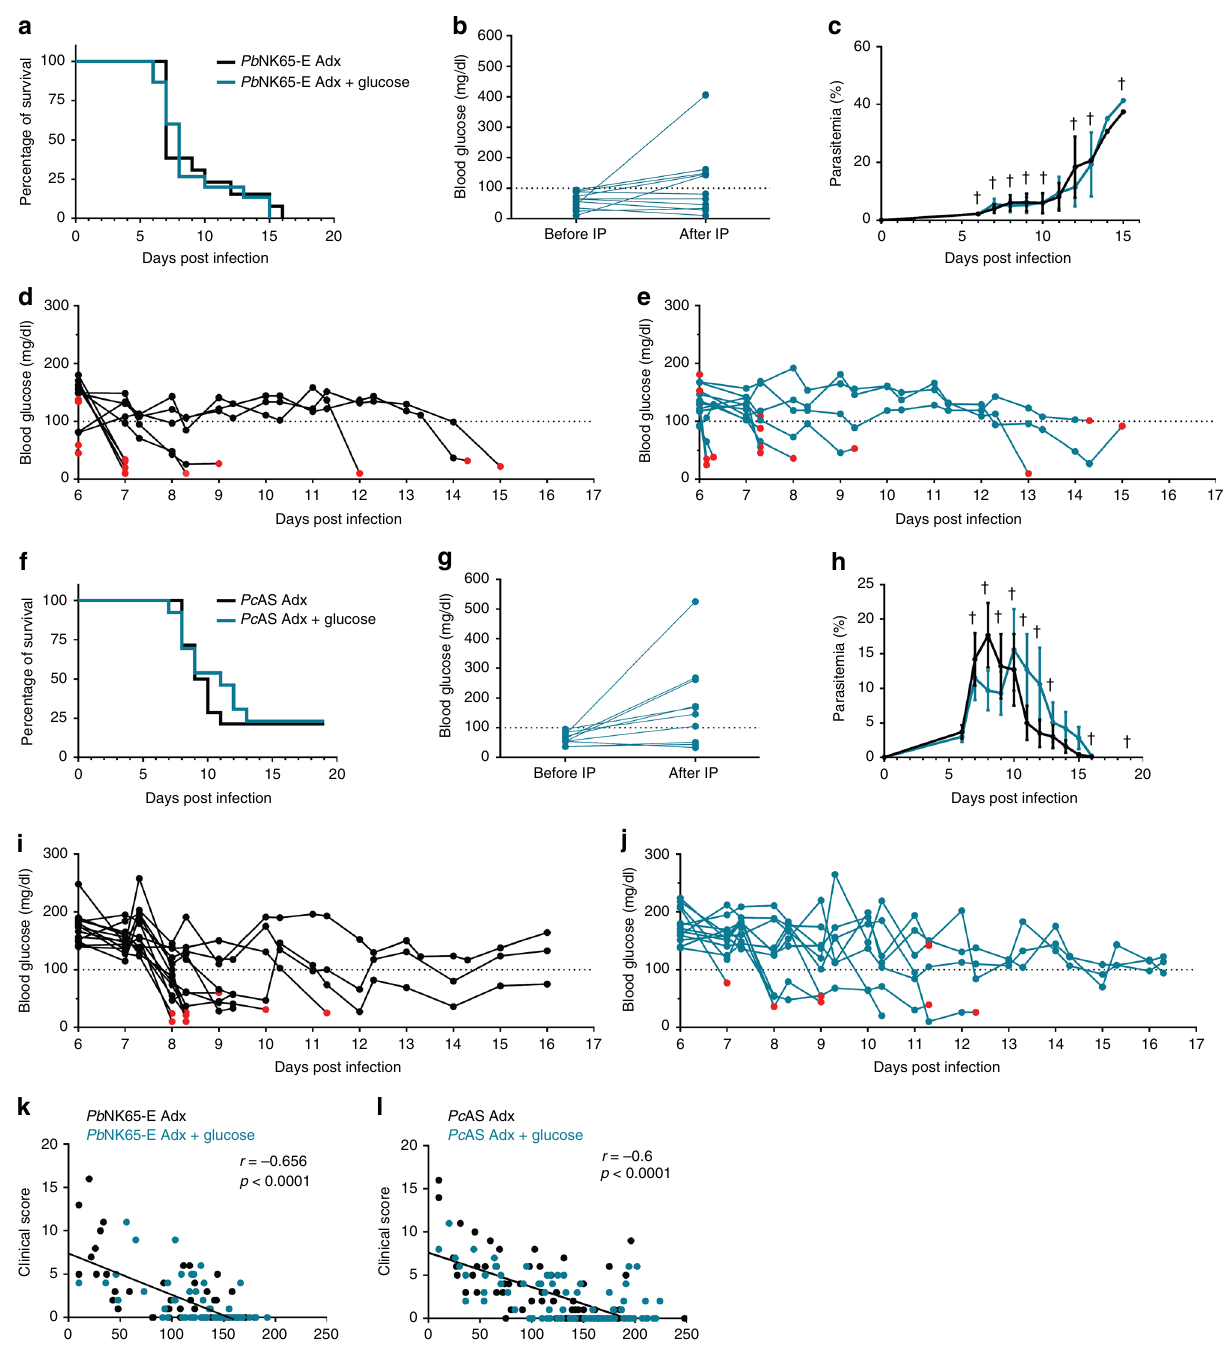
Fig. 6 Supplementation with glucose does not rescue from hypoglycemia or lethality in infected Adx mice. Adx BALB/c mice mice were infected with Pb NK65-E ( a – e and k ) and Adx C57BL/6 mice with Pc AS ( f – j and l ). Glucose supplementation was started 5 days p.i. via the drinking water (5% (wt/vol)) and by IP injection of a dose of 2 g/kg if the blood glucose levels fell below 100 mg/dL (dotted lines). In each experiment, non-infected Adx mice were included and these all survived the observation period (not shown). a, f Survival of the mice was monitored daily. b , g Blood glucose levels were measured before and 30 min after the fi rst IP injection of glucose. c , h The peripheral parasitemia of infected mice was determined at the indicated time points. Data are means ± SEM. Daggers ( † ) indicate when at least one mouse died or was euthanized when it reached the humane endpoints. d , e and i , j Morning and afternoon blood glucose levels were measured. Each curve represents the glycemia course of an individual mouse, black curves ( d , i ) for untreated mice and blue curves ( e, j ) for glucose-supplemented mice. Red dots indicate the last glucose measurement before death. k, l Spearman correlations between blood glucose levels of both glucose-supplemented and untreated mice and the clinical score. Spearman r - and p -values are shown. Graphs represent two separate experiments and the numbers of mice are as follows: n = 4 for uninfected controls, n > 10 for infected Adx without or with